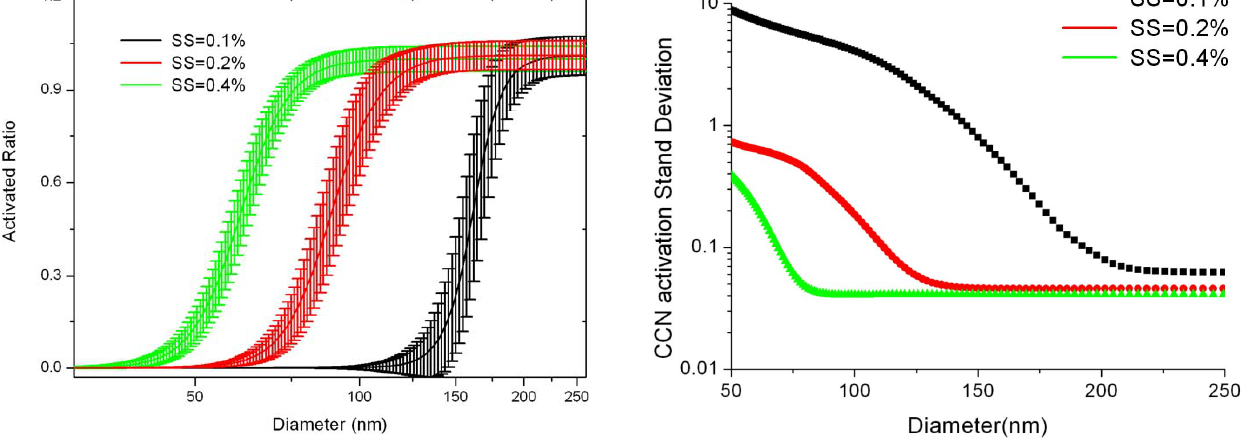
Fig. 5. The calculated stand deviation of size-resolved CCN activa- Fig.5 the calculated stand deviation of size ‐ resolved CCN activation under of 0.1%, 3 tion under of 0.1%, 0.2% and 0.4% 0.2% and 0.4% respectively 4